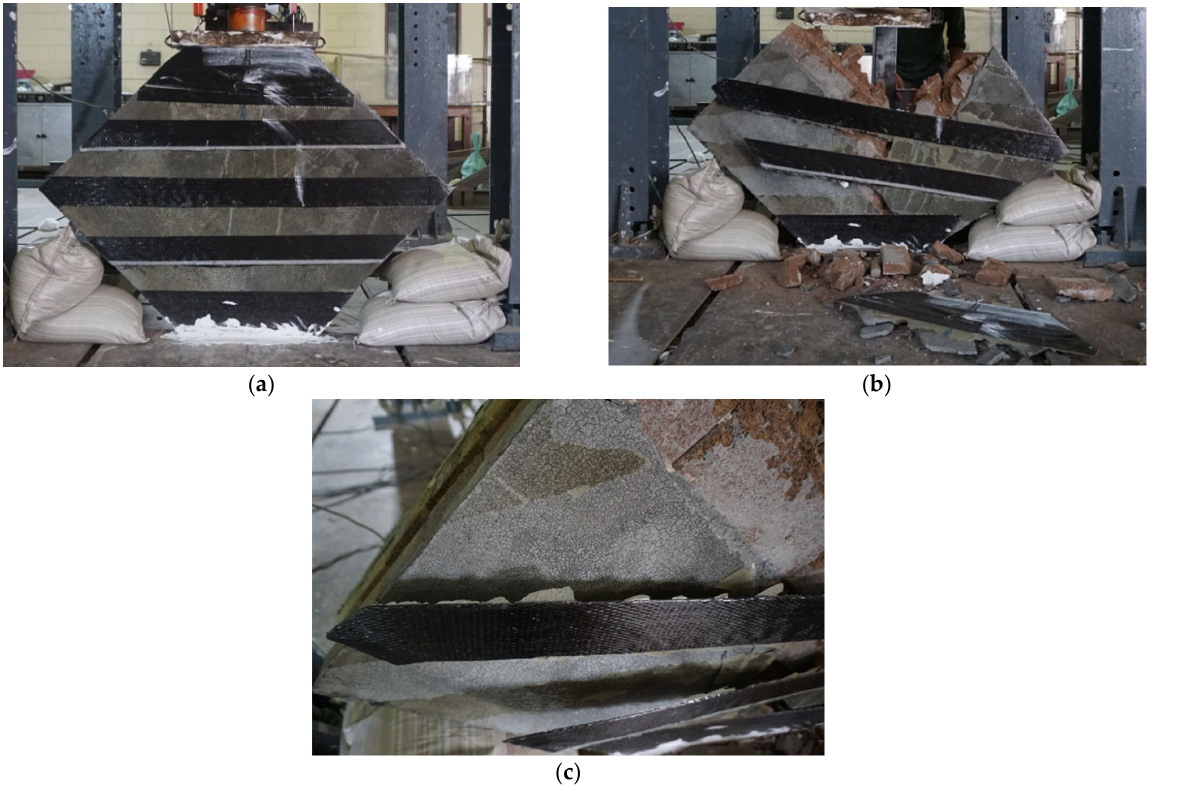
Figure 15. Ultimate failure modes of W ‐ PC1 ‐ 10 ‐ CFRP ‐ 2S wall: ( a ) Before damage at 470 kN ( b ) Damage